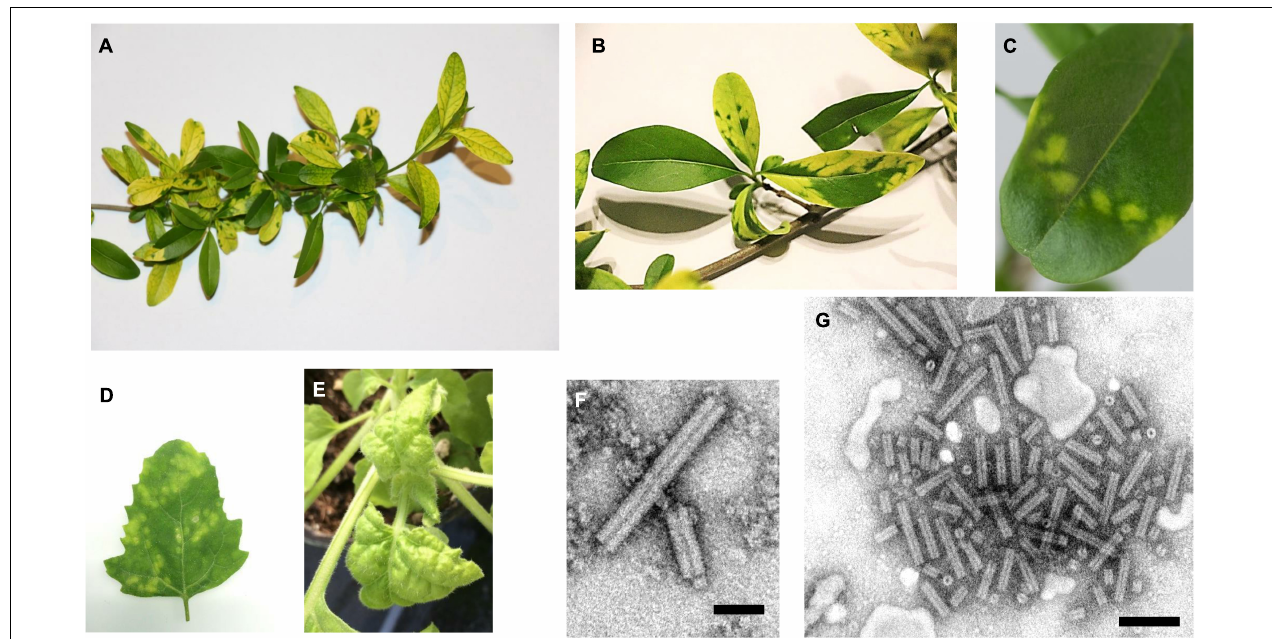
FIGURE 1 | Ligustrum mosaic virus (LigMV) disease symptoms and virion morphology. (A–C) Ligustrum vulgare plants collected near Nyon (Switzerland) in 2015. (D) Chenopodium quinoa and (E) Nicotiana benthamiana infected with LigMV via mechanical inoculation with sap extract from the symptomatic leaves of L. vulgare . Photographs were taken 15 (D) and 10 (E) days post inoculation. (F,G) Electron micrographs of purified LigMV particles stained with phosphotungstic acid. The size bars represent 50 nm (F) and 100 nm (G)